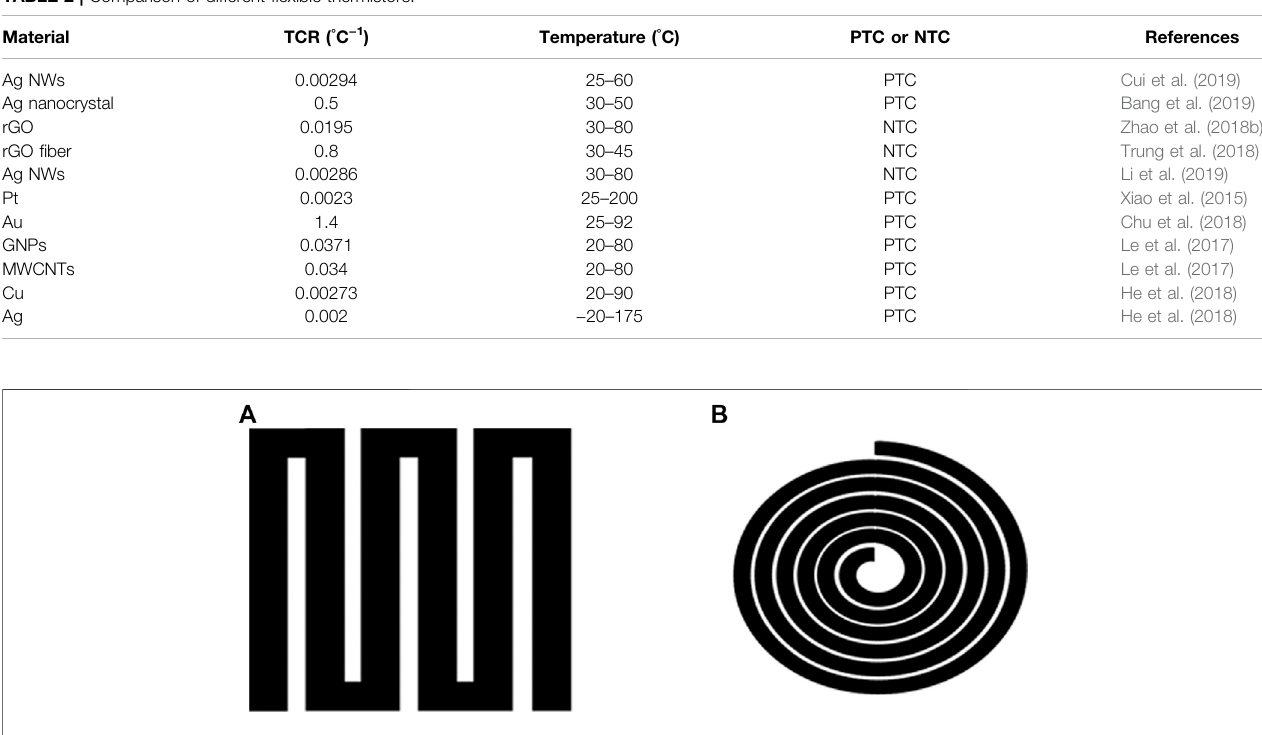
FIGURE 3 | Structure diagram of thermistor. (A) Spiral structure and (B) serpentine structure.